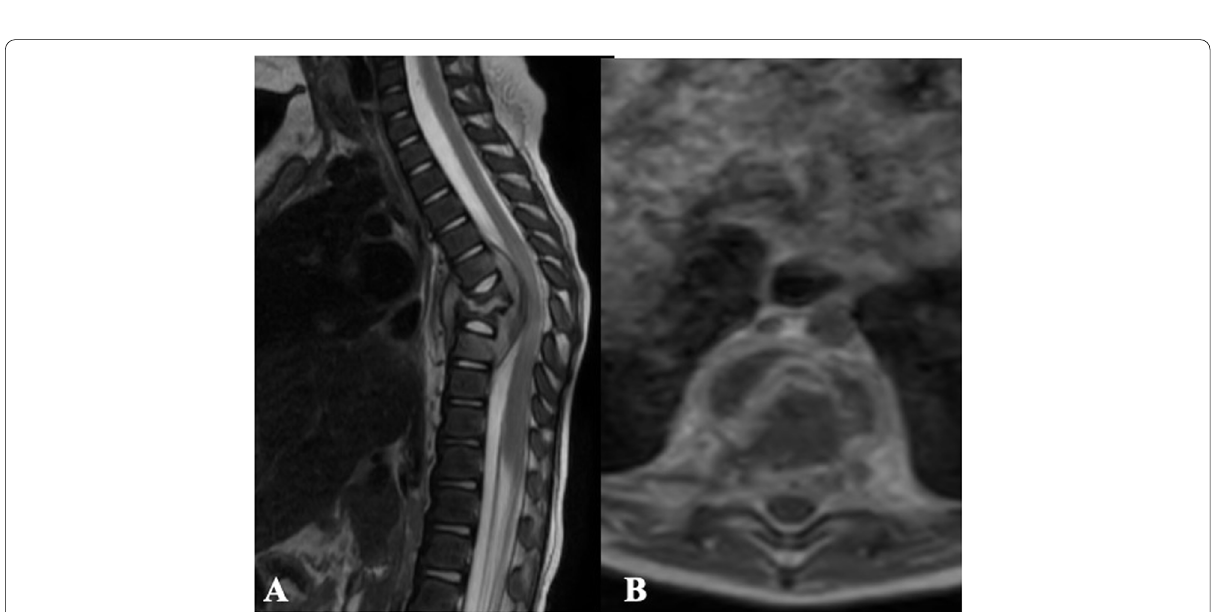
Fig. 3 A Sagittal T2‑WI and B axial post contrast T1‑WI. A prevertebral and epidural collection with enhancing wall with destruction of the D7 and D8 bodies. Also, the related spinal cord signal is compressed displaying abnormal bright signal signifying myelopathic